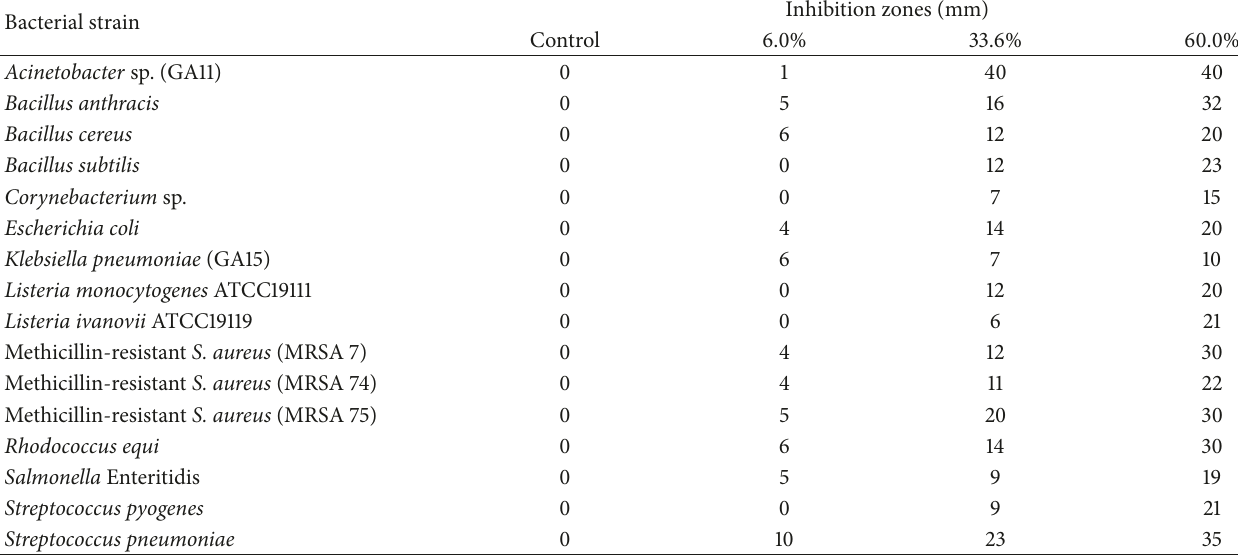
Table 2: Results of antibacterial analysis of pure CA and CA impregnated with carvacrol. Bacterial